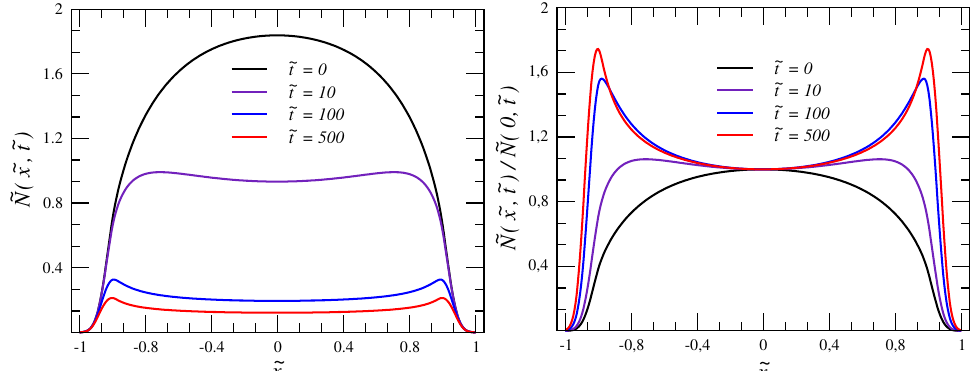
Figure 4: Spatial density profile ˜ N ( ˜ x , ˜ t ) (left panel) and its rescaled version ˜ N ( ˜ x , ˜ t ) / ˜ N ( 0, ˜ t ) for ˜ t = 0,10,100 and 500 and ω =